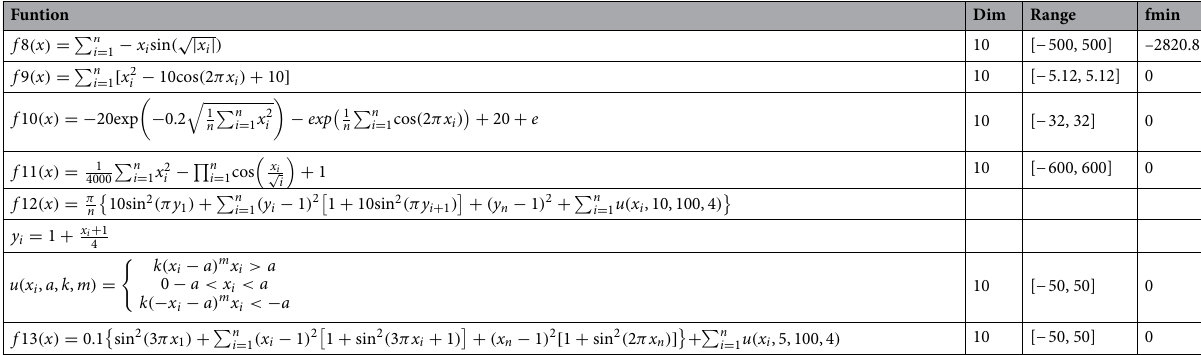
Table 3. Multi-modal test functions.